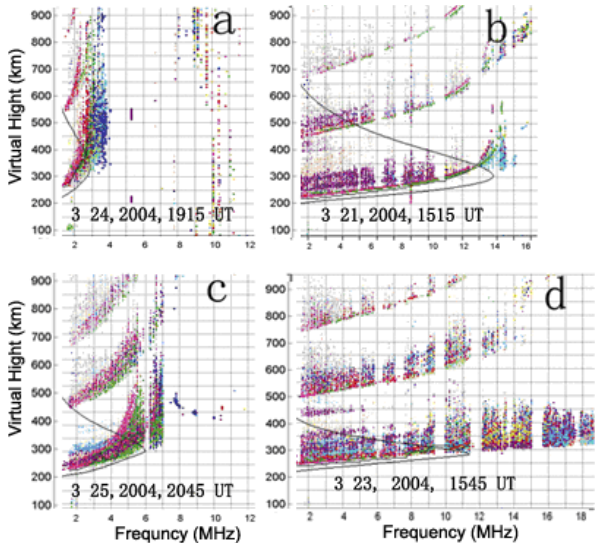
Fig. 1. Examples of the four types of spread F observed in Hainan, (a) for FSF, i.e., the intensity of spread increases with frequency and the critical frequencies are not definable, (b) for RSF, i.e., diffuse echoes at lower frequency with clear critical frequencies, (c) for MSF, which is mixed by FSF and RSF, and (d) for SSF, defined details in